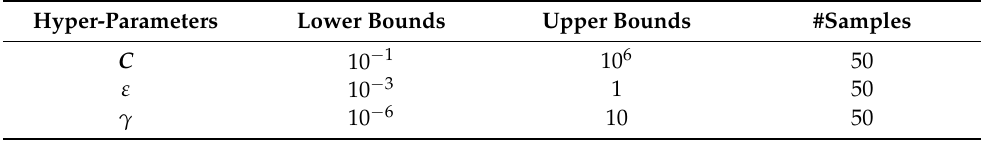
Table 4. Specifications of the hyper-parameter search space. Hyper-Parameters